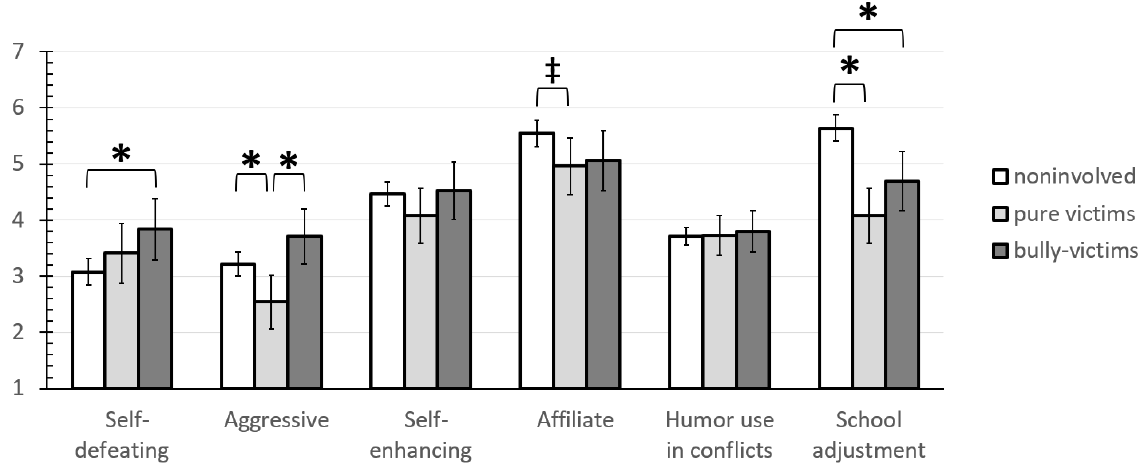
Figure 5. ANCOVA results: Marginal means of bullying-related role groups regarding humor styles